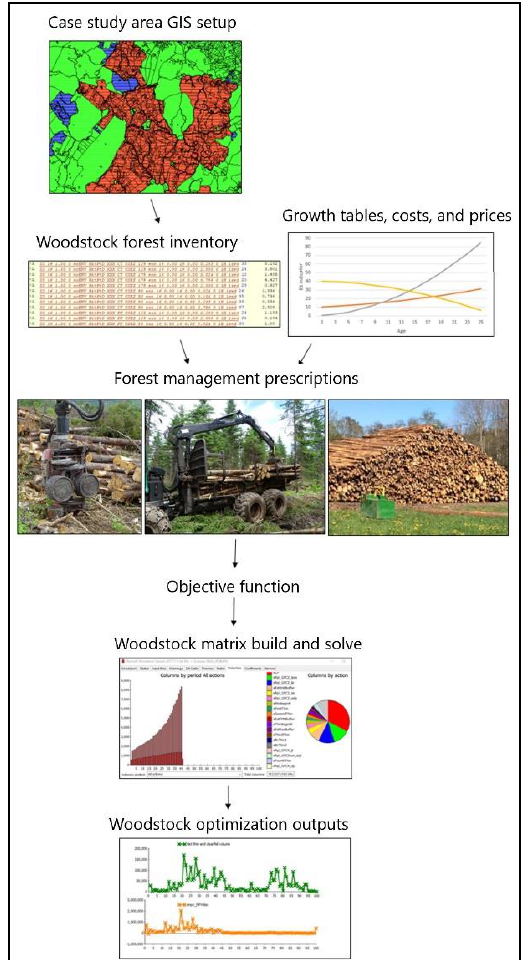
Figure 2. Components required to build a Woodstock forest management decision support system model and generate and solve the matrix to generate outputs for